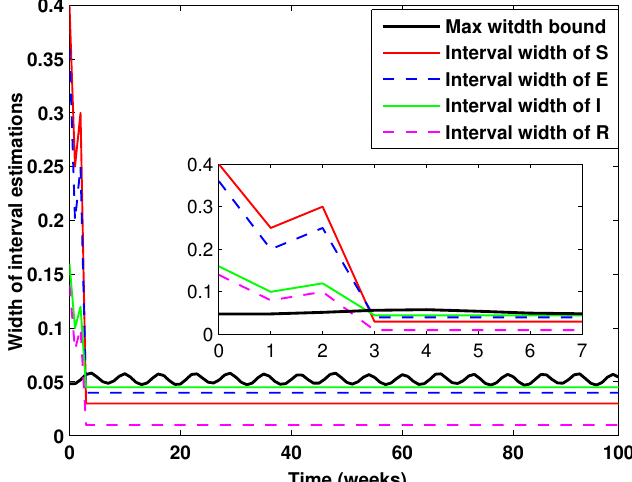
Figure 4. Lower-bound error: (a) proposed method; (b) method given in [28].